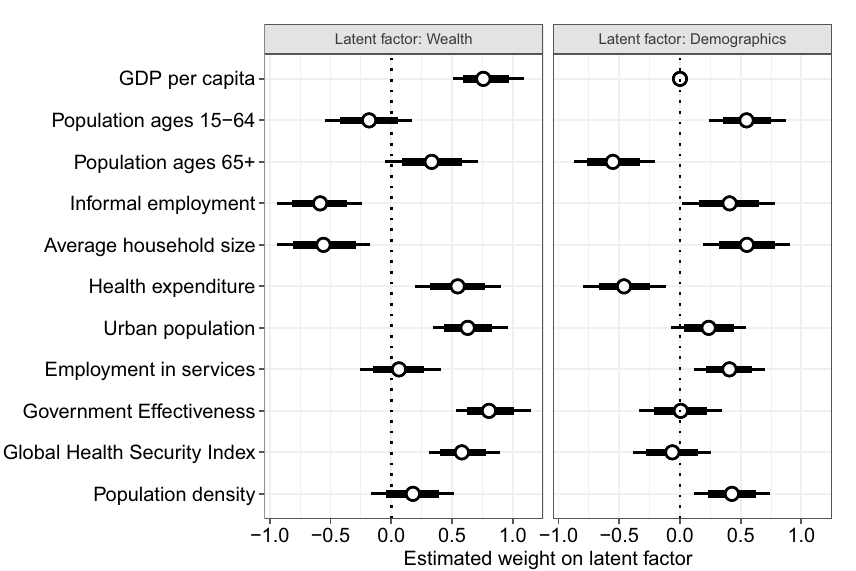
Figure 5. Estimated weight on latent factors (posterior mean as dots with 80% and 95% credible interval as thick and thin lines,